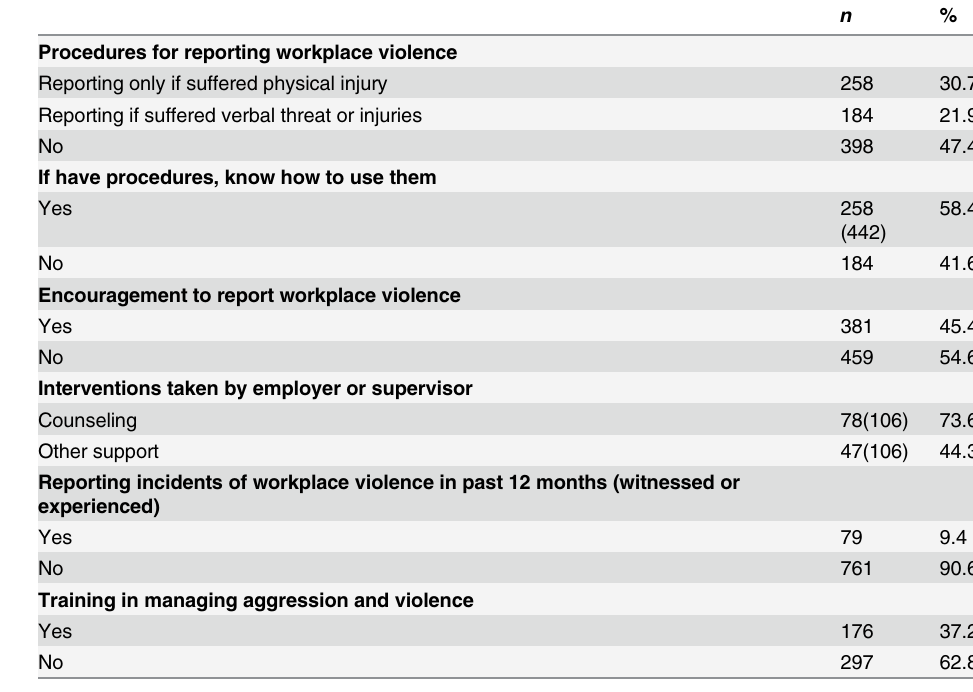
Table 4. Policies, procedures, and intervention strategies against workplace violence.